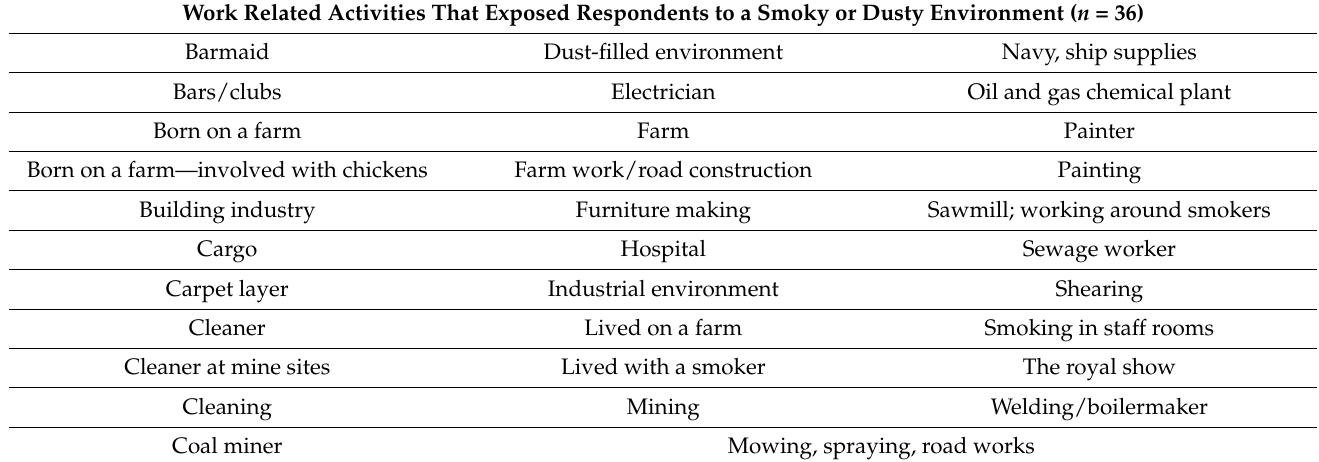
Table 2. Type of work-related activities that exposed respondents to a smoky or dusty